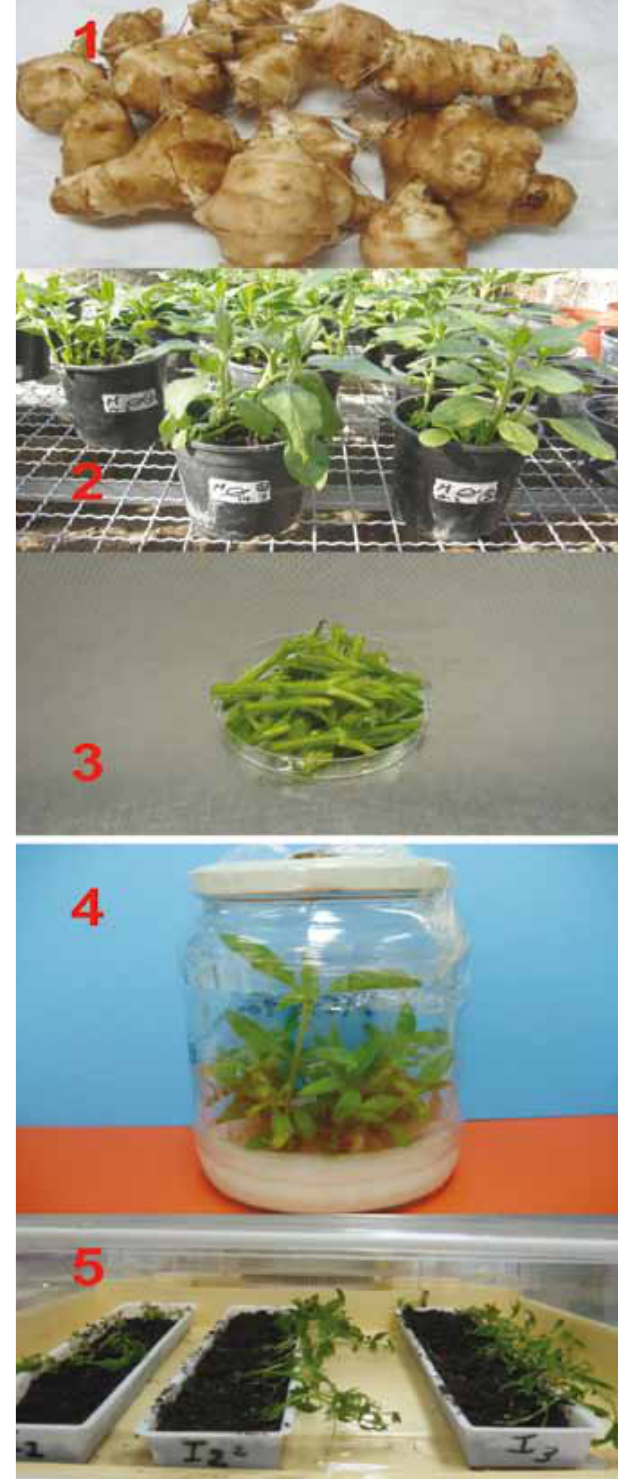
Fig. 3 : In vitro propagation of Jerusalem artichoke using stem nods: clean and surface sterilized harvested tubers (photo 1); transplants produced from tubers as a source of stem nod explants (photo 2); disinfected stem nod explants in laminar air flow (photos 3); acclimatization of in vitro plants (on MS medium containing starch, Photo 4) and using micro-farm (Photo 5) (Photos by N. Abd Alla, Demonstration Garden, Agricultural Botanics, Plant Physiology and Biotechnology Dept., Debrecen Uni., Hungary,